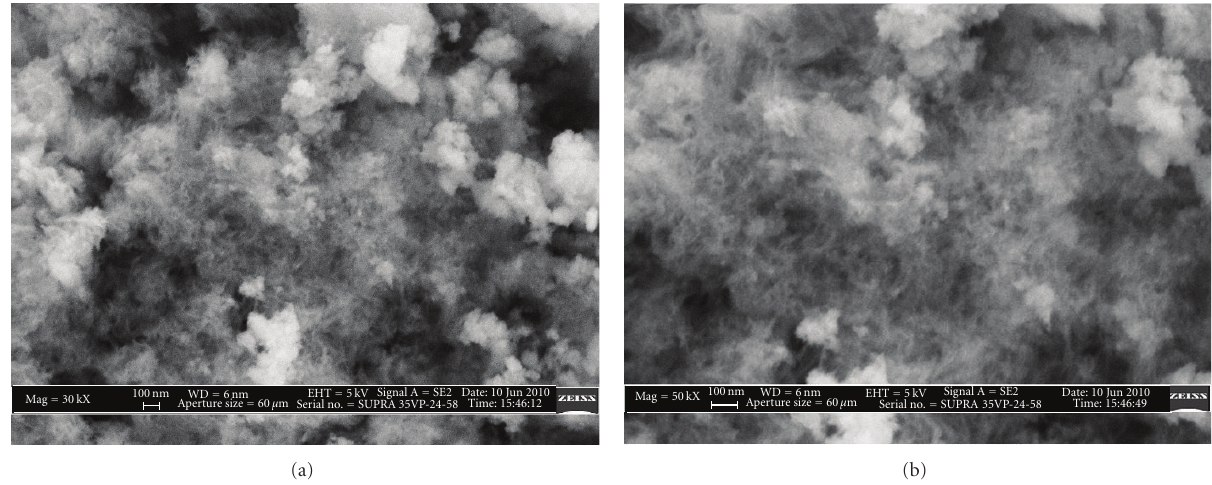
Figure 2: SEM images of TiO 2 nanotubes/silica gel synthesized by the hydrothermal reaction at 130 ◦ C for 3h. (a) Before photocatalytic degradation of phenol and (b) after photocatalytic degradation of